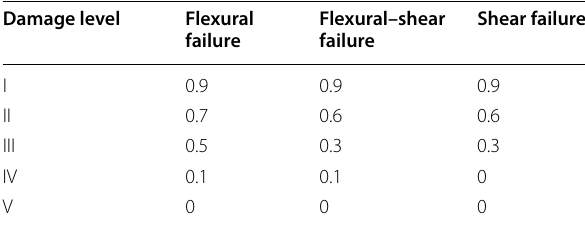
Table 4 Suggested reduction factors of seismic capacity for damaged RC